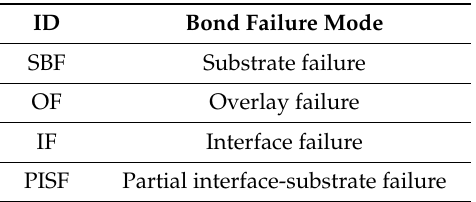
Table 4. Pull-o ff test bond failure modes.